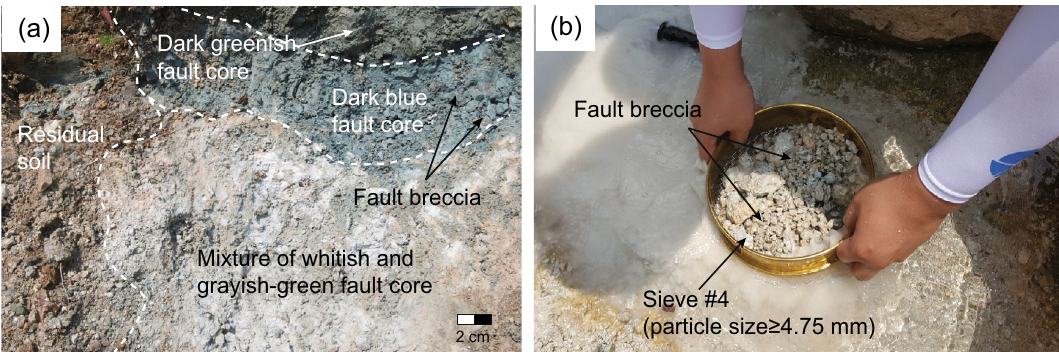
Figure 1. ( a ) Outcrop photograph of fault core sampled from the Ocheon Fault Zone for the manufacture of artificial specimens. ( b ) Breccia from the fault core zone classified using sieve #4 (≥ 4.75